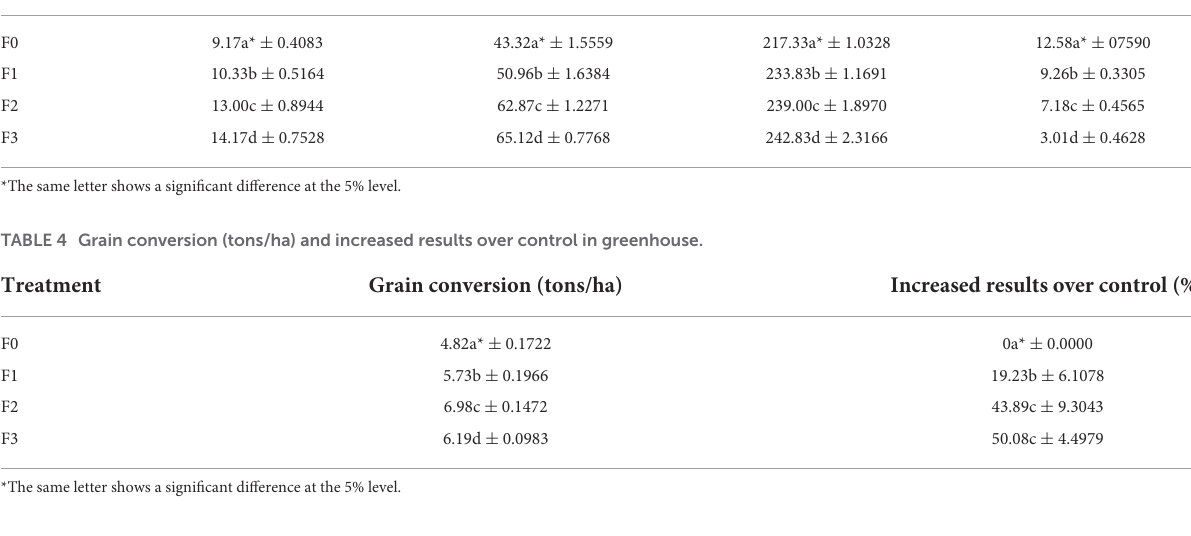
TABLE 3 Effect of treatment on production in Week 18 on Bali red rice in greenhouse. Treatment